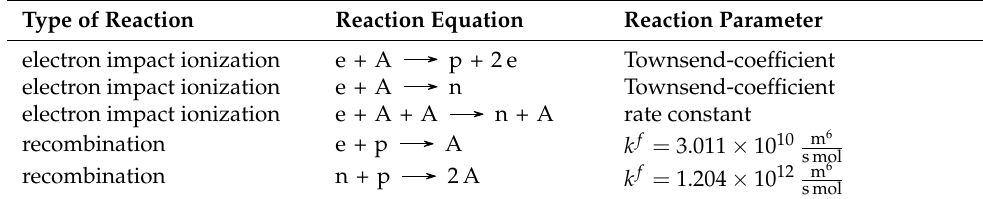
Figure 2. Geometry of the field physical calculated area. Table 1. Types of reaction with associated reaction equations and reaction